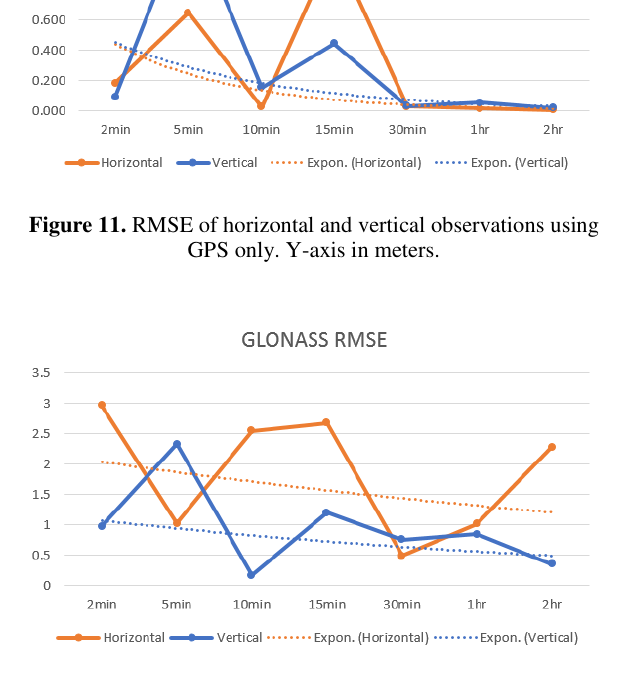
Figure 12. RMSE of horizontal and vertical observations using GLONASS only. Y-axis in meters.